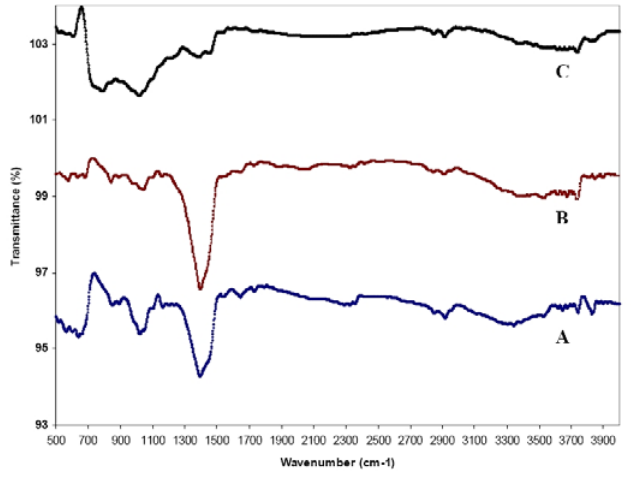
Fig. 6 Comparative ATR-FTIR diagram of untreated (A) and pyrrole plasma treted paper (B: 25 W, C: 50